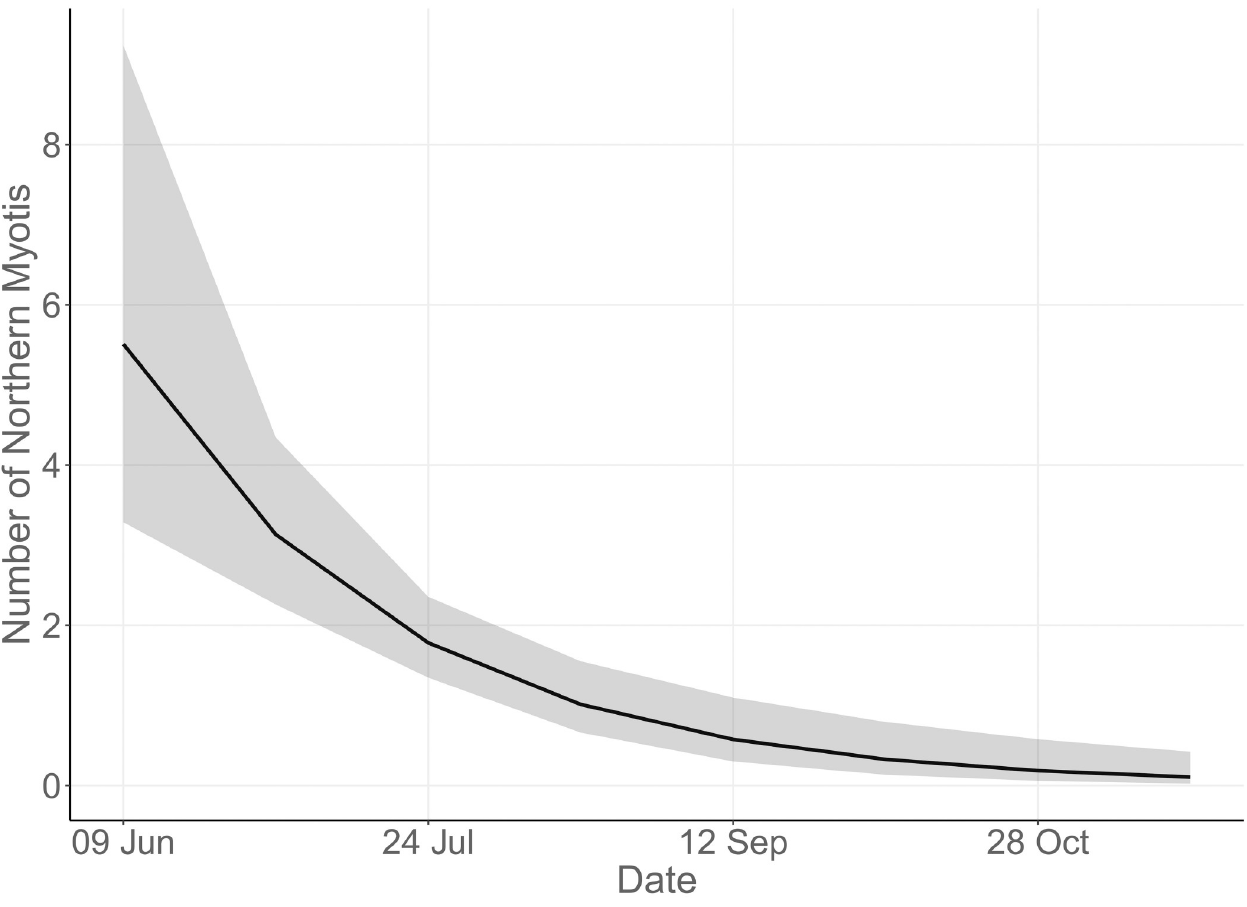
Fig 5. Seasonal trends in northern myotis emergence counts. The number of northern myotis counted exiting roost trees in central Pennsylvania declined as the year progressed (first count occurred on 9 June). Data shown are predicted values with a 95% confidence interval generated from a generalized linear mixed